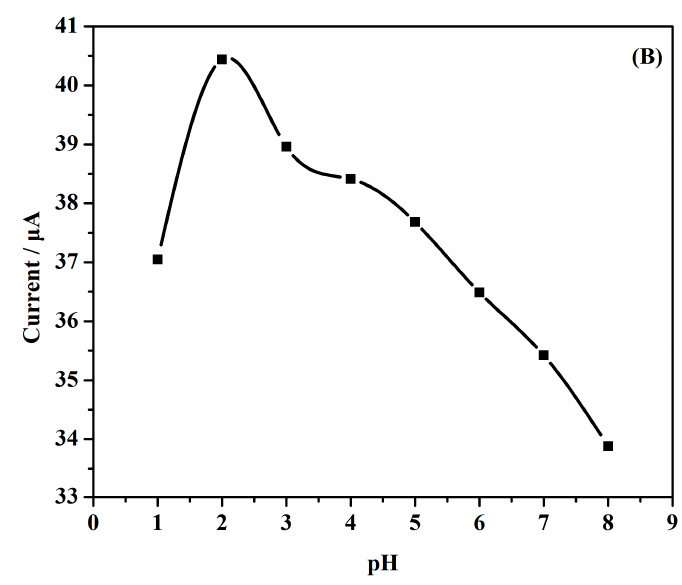
Figure 7. ( A ) CVs of a solution of 1.0 × 10 − 3 mol·L − 1 SAM AuNPs/Gr/GCE at various buffered pHs: (a)